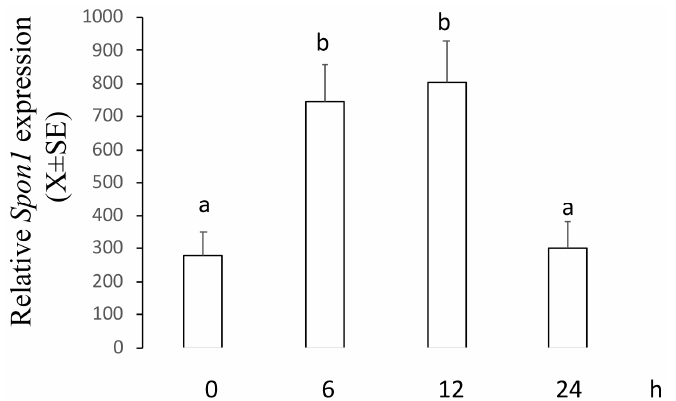
Figure 2. Levels of Spon1 in the Ishikawa cells treated with 2ME 5 uM during 0, 6, 12, or 24 h and then processed by real ‐ time PCR. This experiment consisted of 5 replicates. a b, p < 0.05. Note that Spon1 was increased at 6 and 12 h after treatment.